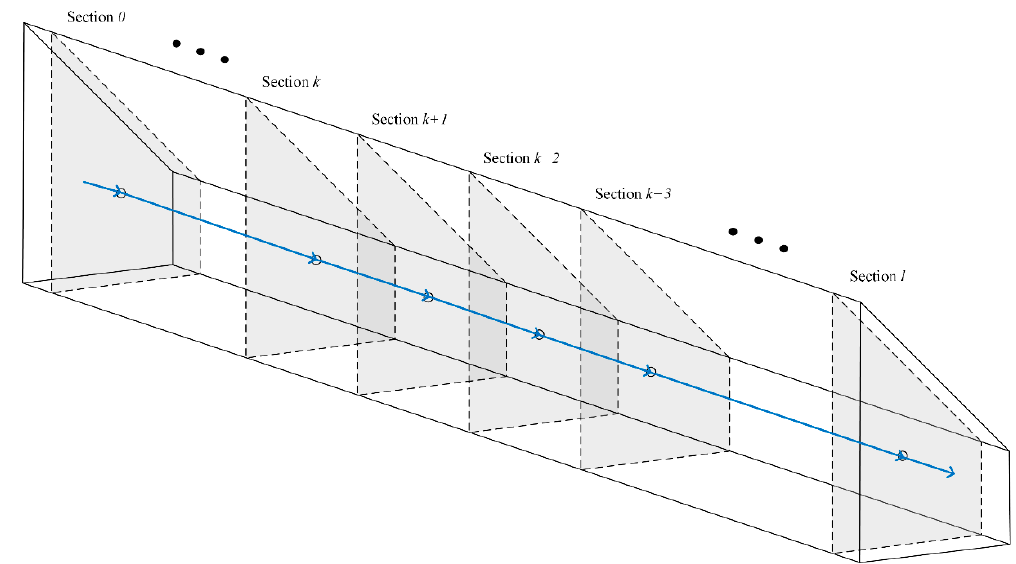
Figure 16. Path generation of welding torch with multi-section interpolation.